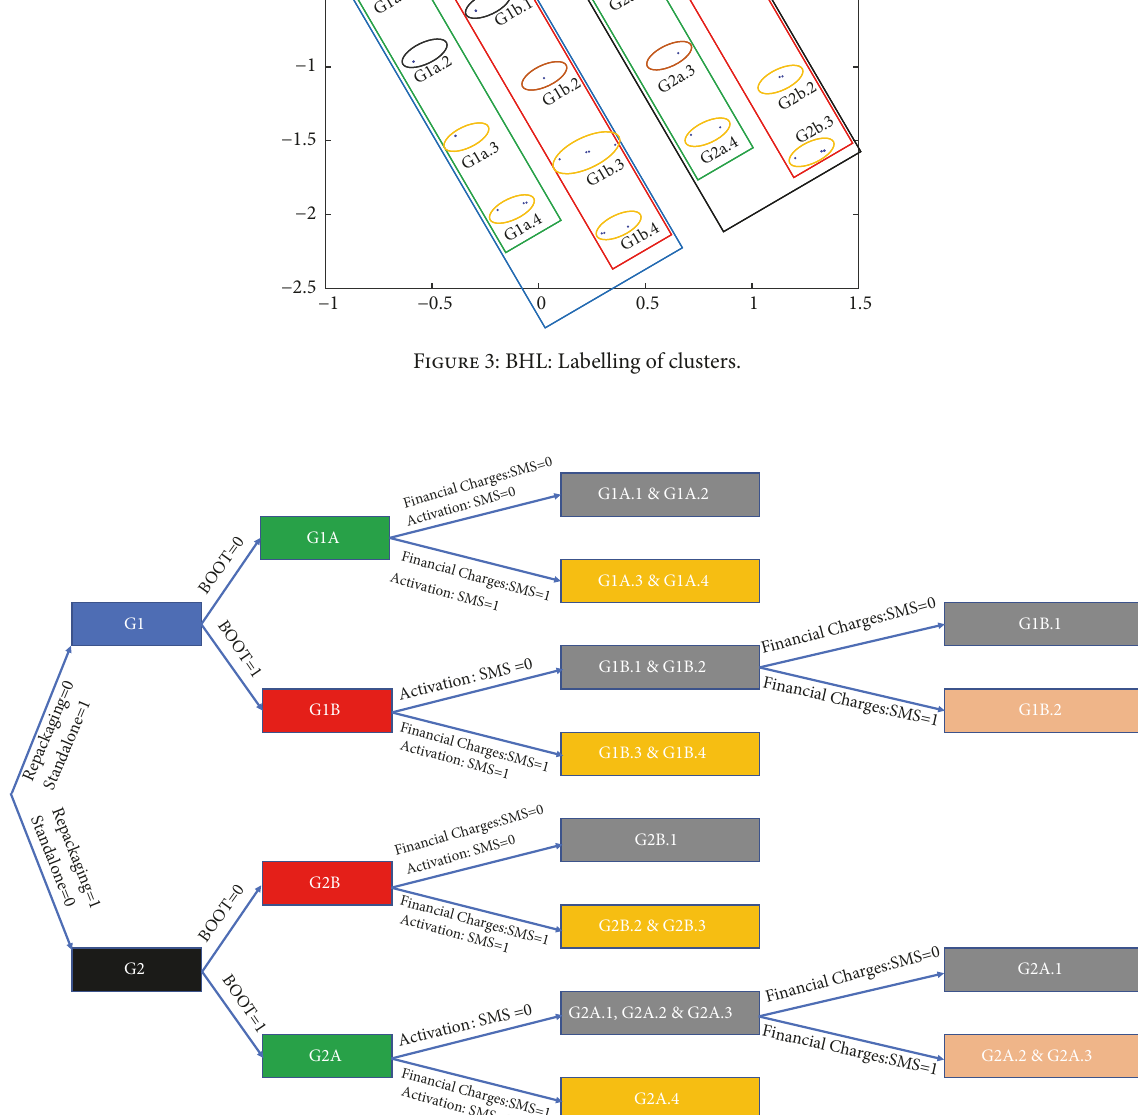
Figure 4: Schematic clustering and relevant features from BHL